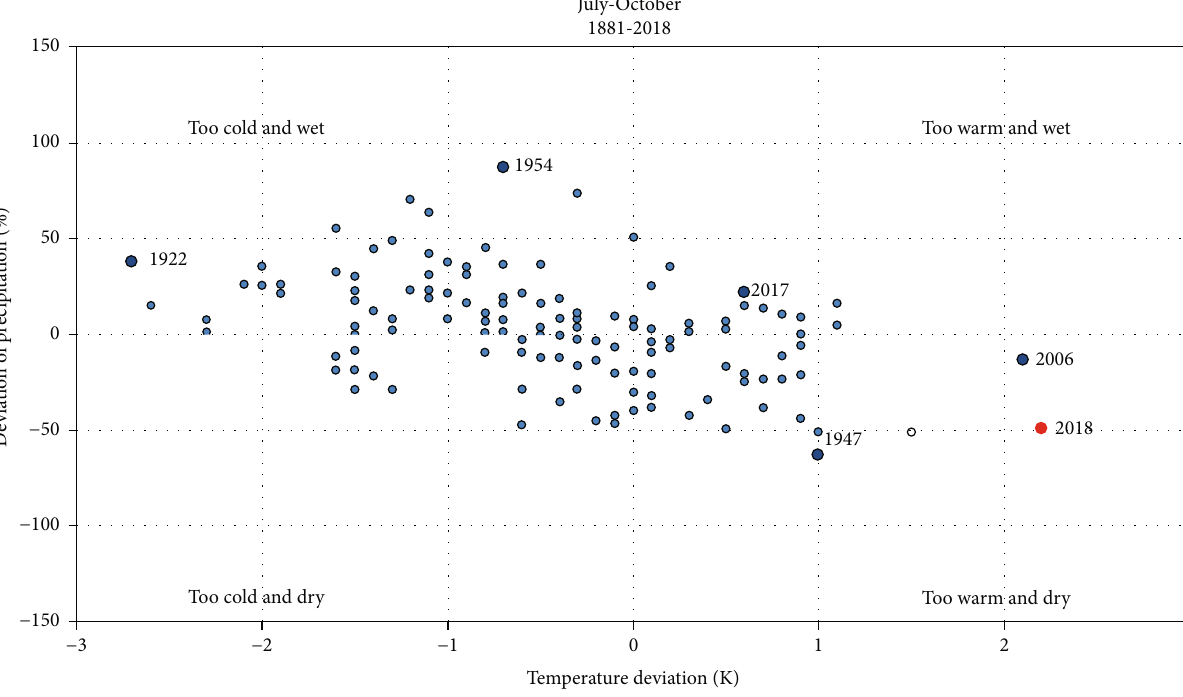
Figure 3: Deviation from long-standing average: summer of 2018 as an exceptional summer. Thermopluviogram of the Free State of Saxony, Germany (July-October, 1881-2018); DWD (German Weather Service, personal comm.